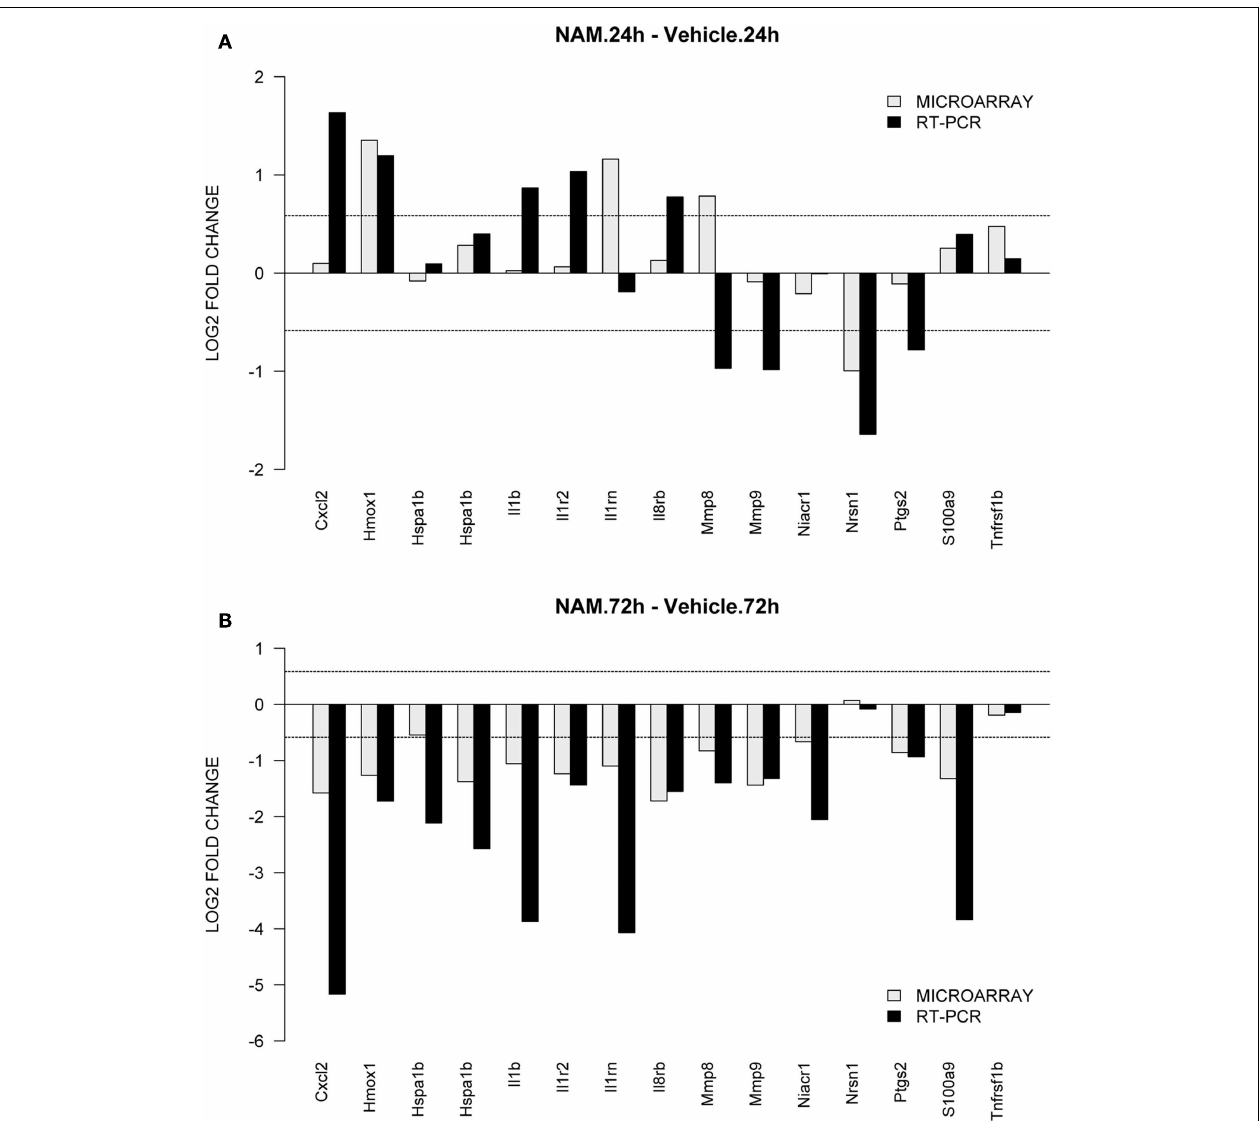
FIGURE 6 |TaqMan based RT-PCR validation of the microarray data for the selected genes: Cxc12, chemokine (C-X-C motif) ligand 2; Hmox1, heme oxygenase 1; Hspa1b, heat shock protein 1b; Il1b, interleukin 1beta; Il1rn, interleukin 1 receptor antagonist; Il8rb, interleukin 8 receptor beta; Mmp8, matrix metallopeptidase 8; Mmp9, matrix metallopeptidase 9; Niacr1, niacin receptor 1; Nrsn1, neurensin 1; Ptgs2, prostaglandin-endoperoxide synthase 2; S100a9, S100 calcium binding proteinA9;Tnfrsf1b, tumor necrosis factor receptor